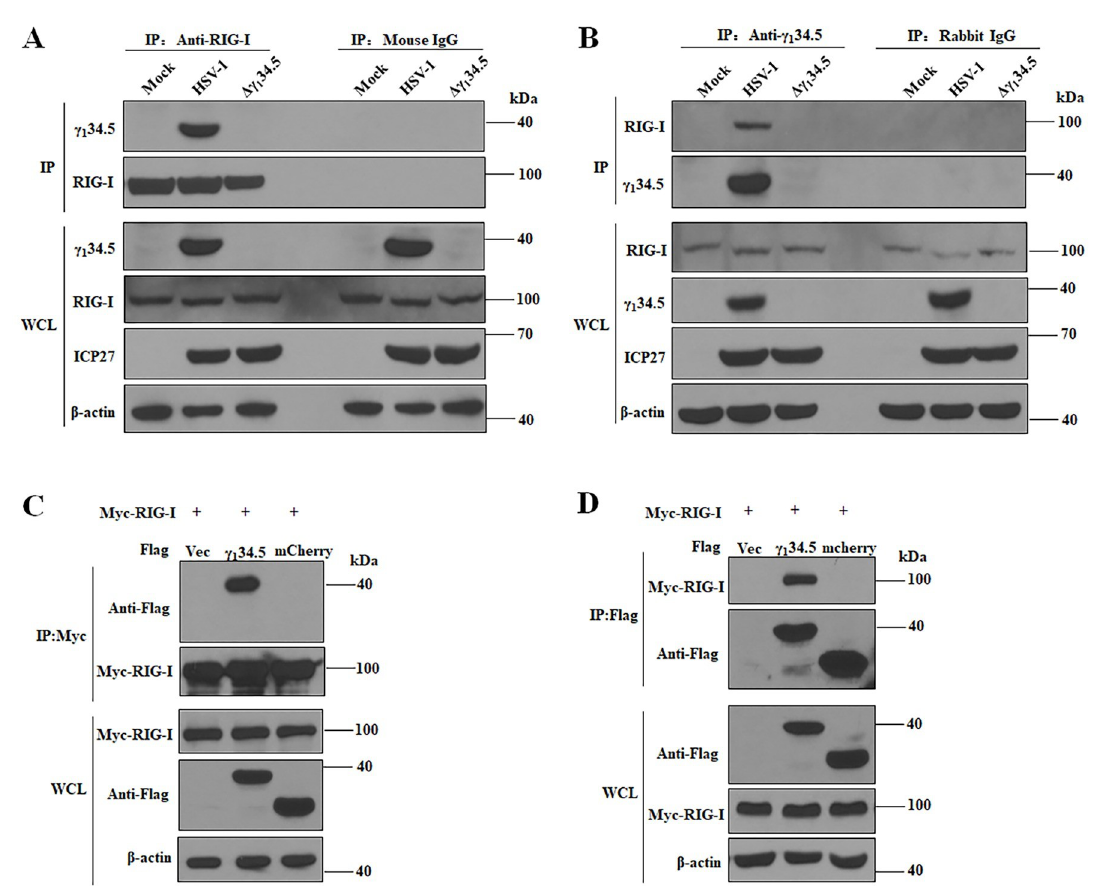
Fig 4. The γ 1 34.5 protein interacts with RIG-I. (A and B) The γ 1 34.5 protein interacts with endogenous RIG-I in infected cells. MEFs were infected with wild-type HSV-1 or Δγ 1 34.5 (10 pfu/cell). At 8 h postinfection, the cells were processed for immunoprecipitation (IP) with anti- RIG-I antibody or normal mouse IgG (A), or with anti- γ 1 34.5 antibody or normal rabbit IgG (B). Whole-cell lysates (WCL) and precipitated proteins were probed with antibodies against RIG-I, γ 1 34.5, ICP27 and β -actin. (C and D) HSV-1 γ 1 34.5 interacts with RIG-I in the absence of other viral proteins. HEK-293T cells were transfected with Myc-RIG-I together empty vector (Vec), Flag- γ 1 34.5 or Flag-mCherry for 36 h. Cell lysates were subjected to immunoprecipitation (IP) with anti-Myc antibody (C) or anti-Flag antibody (D). Precipitated proteins and WCLs were probed with antibodies against Flag, Myc, and β -actin. The data are representative of results from three independent experiments.